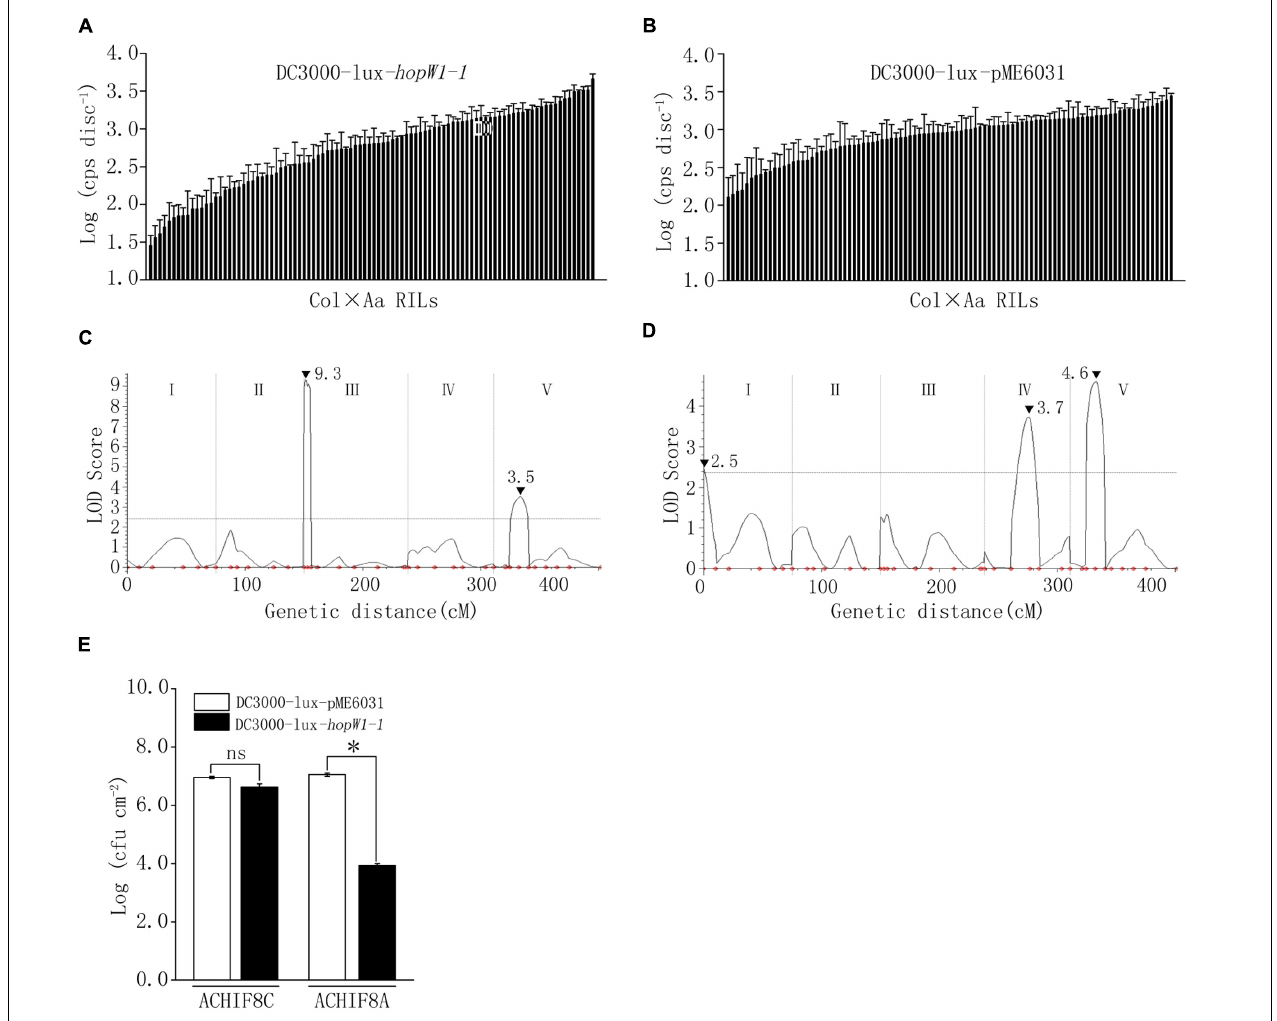
FIGURE 6 | The interaction between Qpm3.1 and hopW1-1 contributed to the quantitative disease resistance. (A,B) Continuous distribution of luminescence levels of DC3000-lux- hopW1-1 (A) and DC3000-lux-pME6031 (B) in Col × Aa RILs. Leaves were pressure inoculated with the bacteria at OD 600 = 0.003. Inoculated plants were covered and four leaf discs from each plant were sampled 48hpi for luminescence assay. Data shown are means of results of three repeated experiments. Error bars denote standard deviations ( n = 3). (C,D) QTLs mediating quantitative resistance to DC3000-lux- hopW1-1 (C) and DC3000-lux-pME6031 (D) in Col × Aa RILs. Peak LOD scores are indicated by filled triangles along with their values. (E) Genetic interaction between Qpm3.1 and hopW1-1 restricted bacterial growth in planta . Individuals of HIF family ACHIF8 were genotyped with marker 1.3 Mb tightly associated with locus Qpm3.1 . Plants with Aa-0 genotype (ACHIF8A) and plants with Col-0 genotype (ACHIF8C) were pressure infiltrated with DC3000-lux- hopW1-1 and DC3000-lux-pME6031 at OD 600 = 0.0005. The inoculated plants were covered to keep high relative humidity. Levels of the bacterial population were determined at 72 hpi. Data shown are means ± SD ( n = 8). The asterisk indicates a significant difference between treatments (Student’s t -test, P < 0.05). “ns” denotes no significant difference. This experiment was repeated three times with similar